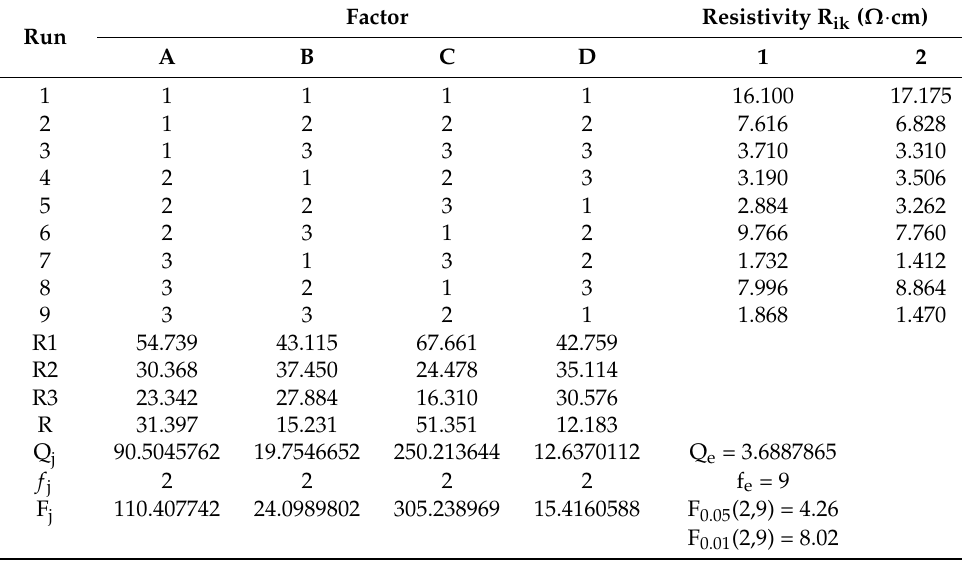
Table 4. Variance analysis of experiment